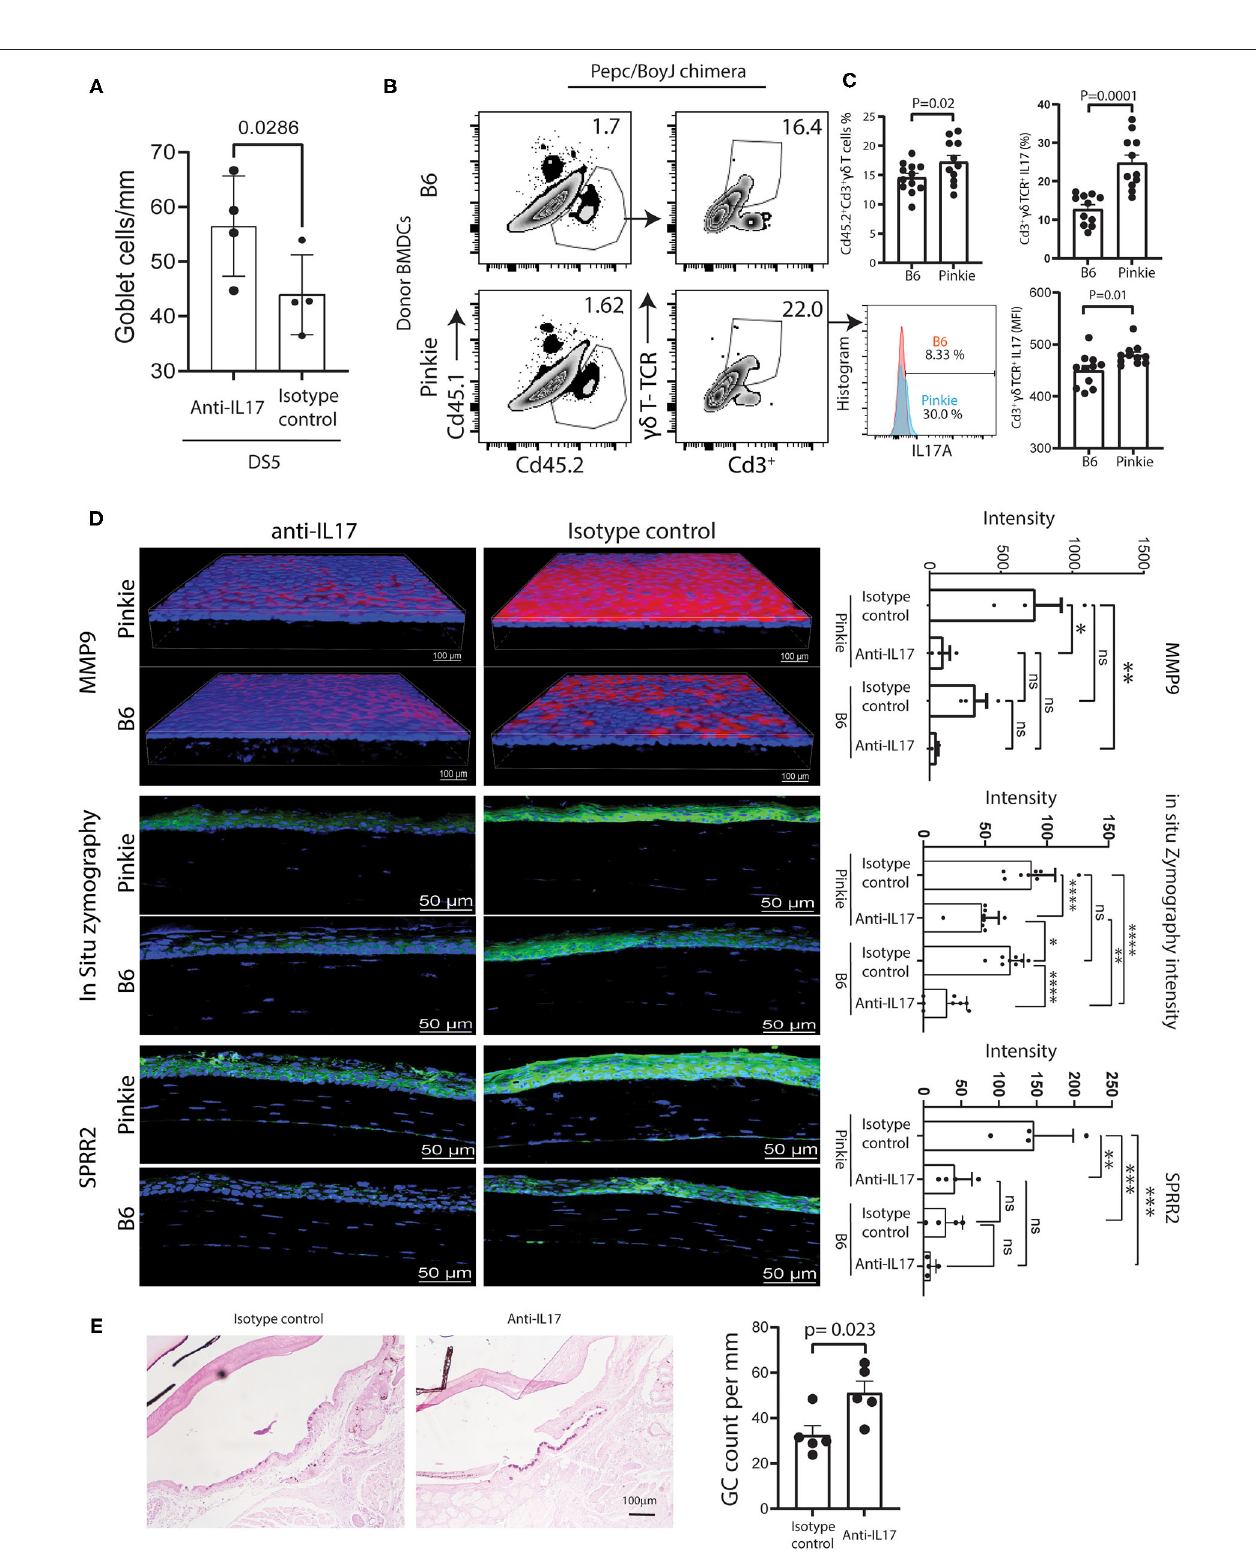
FIGURE 6 | Comparison of γδ T and dry eye signs in bone marrow chimeras. (A) Conjunctival goblet cell number in C57BL/6 mice exposed to desiccating stress (DS) for 5 days (DS5) with or without systemic treatment with anti-IL-17 neutralizing antibody or isotype control as described in the methods. (B) Representative